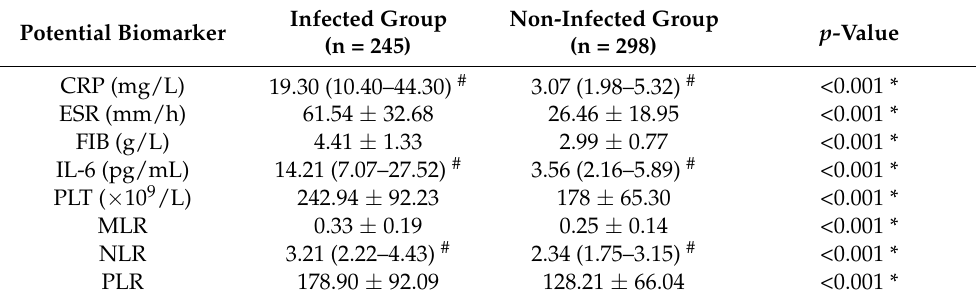
Table 2. Tested biomarkers in the infected and non-infected